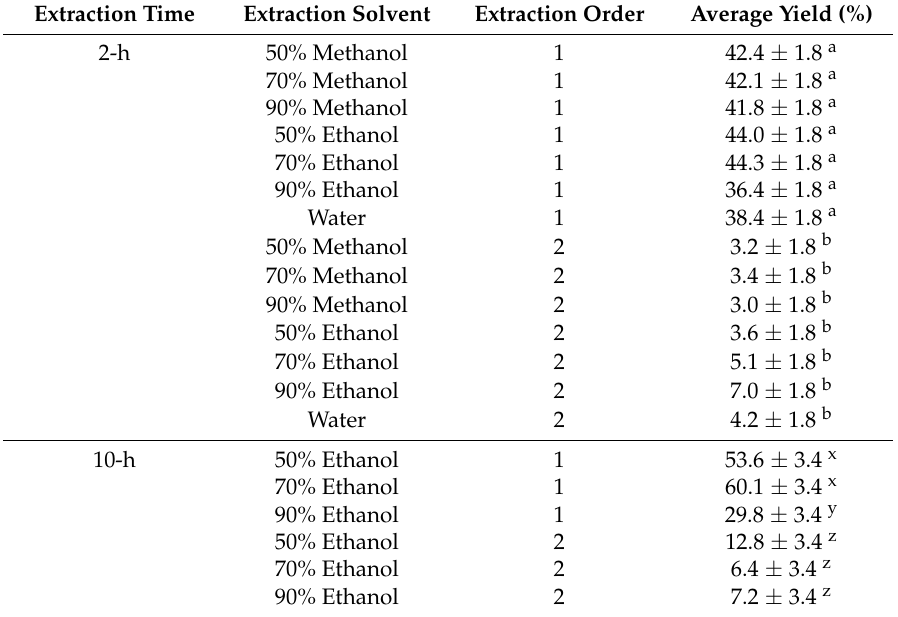
Table 1. The yield of extracts (Mean ± SEM) obtained using solvent extraction methods. a,b Within each extraction and x–z within each extraction time, values that do not share the same letter are significantly different ( p <